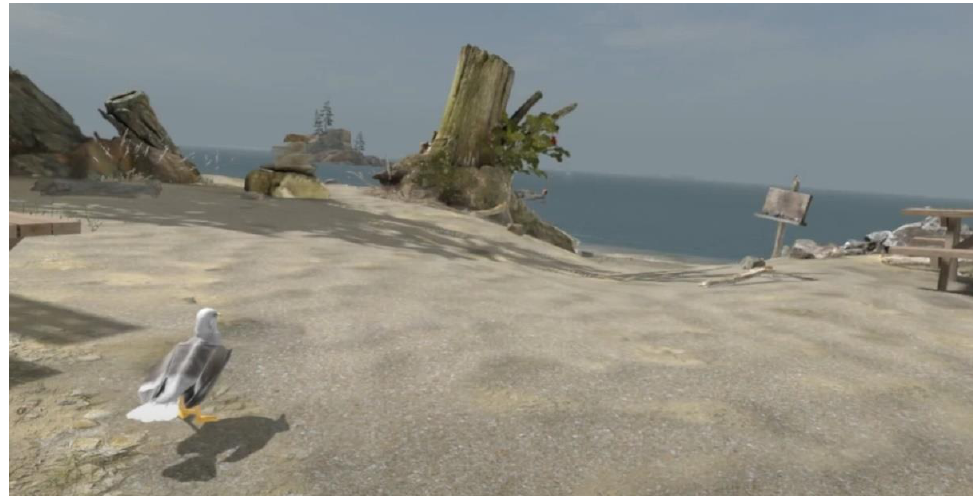
Figure 2. Driftwood beach environment in virtual reality perspective.